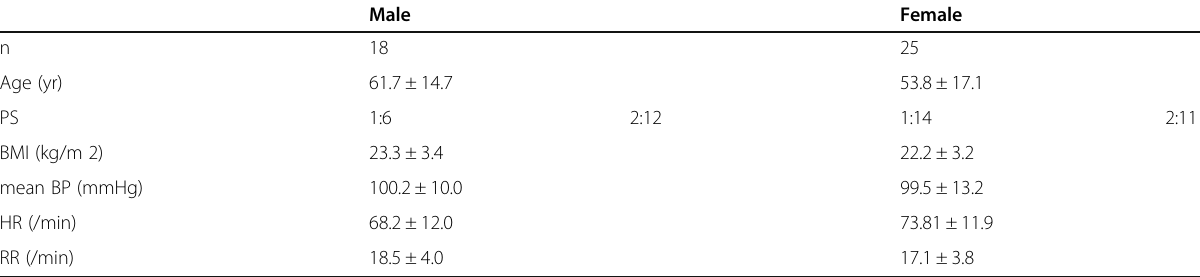
Table 2 Patient demographic by